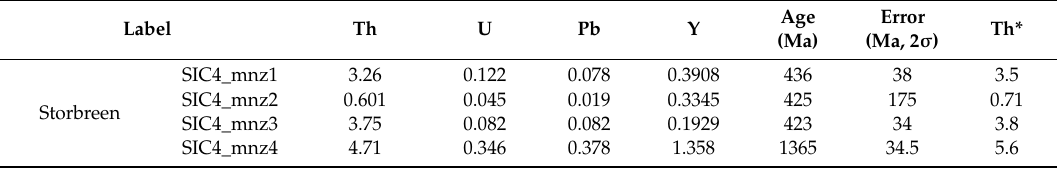
Table A1. Chemical dating of monazite from Storbreen and Recherchebreen glaciers. All measured values are given in weight %. See text for further explanation. Th* is the sum of measured Th and hypothetical